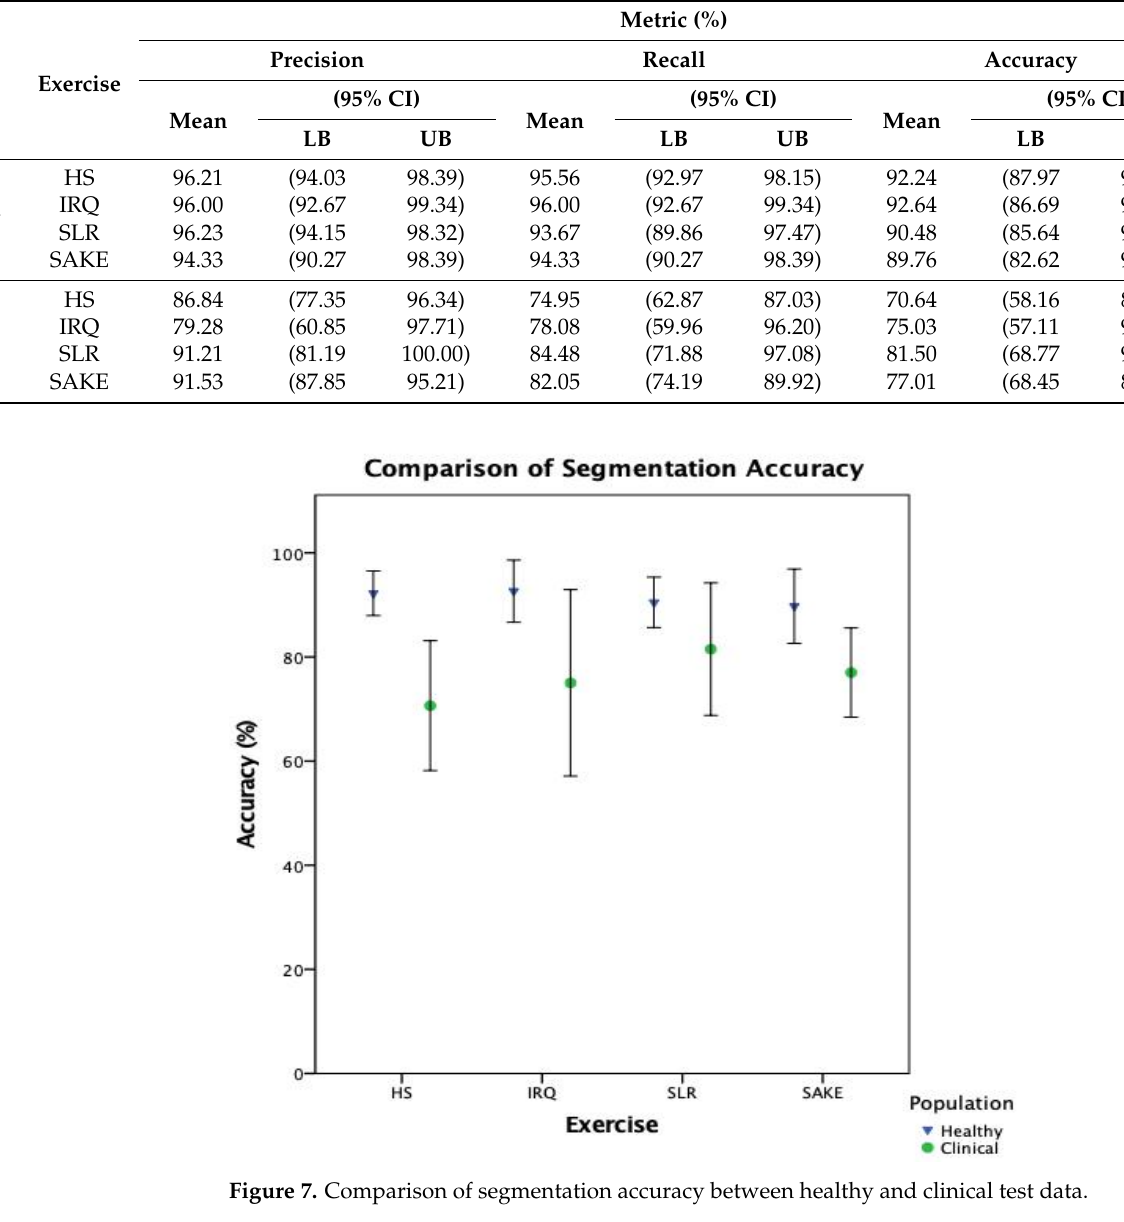
Table 7. Biofeedback model performance: classification results of healthy test data with segments generated automatically.